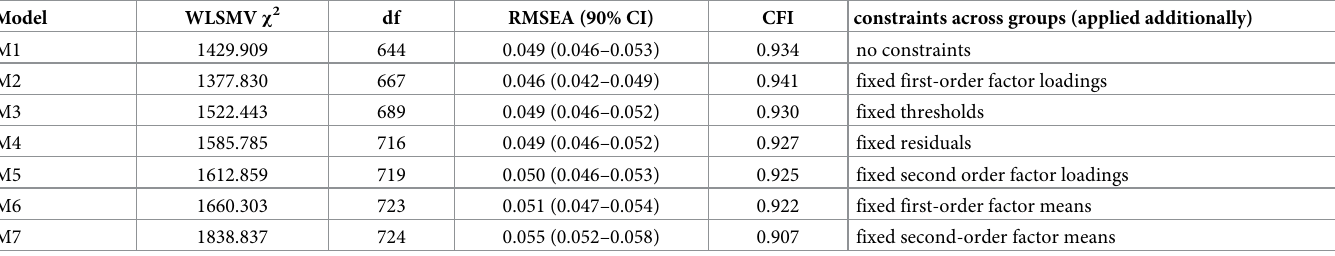
Note. WLSMV–weighted least square with means and variance adjusted; all χ 2 were significant (p < 0.001); RMSEA–root mean square error of approximation; CFI– comparative fit